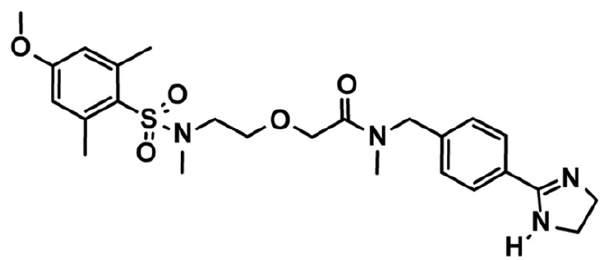
Figure 1. Chemical structure of LF22-0542.